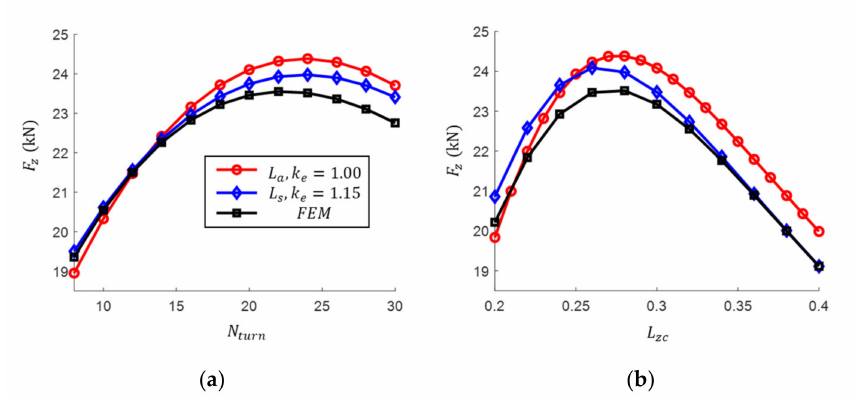
Figure 17. Comparison of the lift force trends of the changes in ( a ) number of turns N turn or ( b ) vertical coil height L zc for the analysis results using the FEM and the SLC